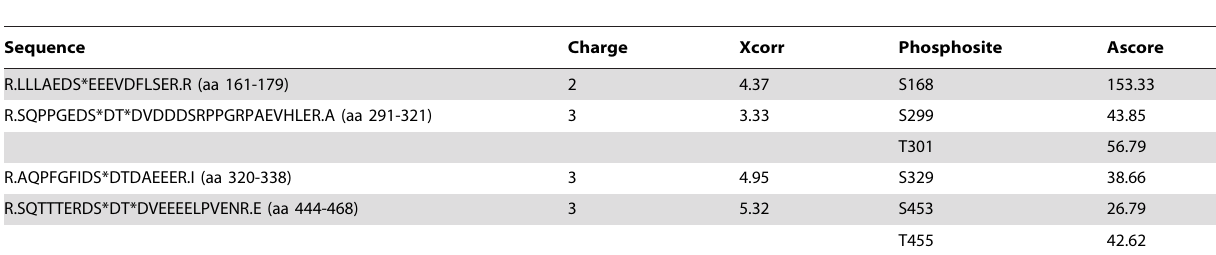
Table 2. MDC1 phosphopeptides identified by mass spectrometry.